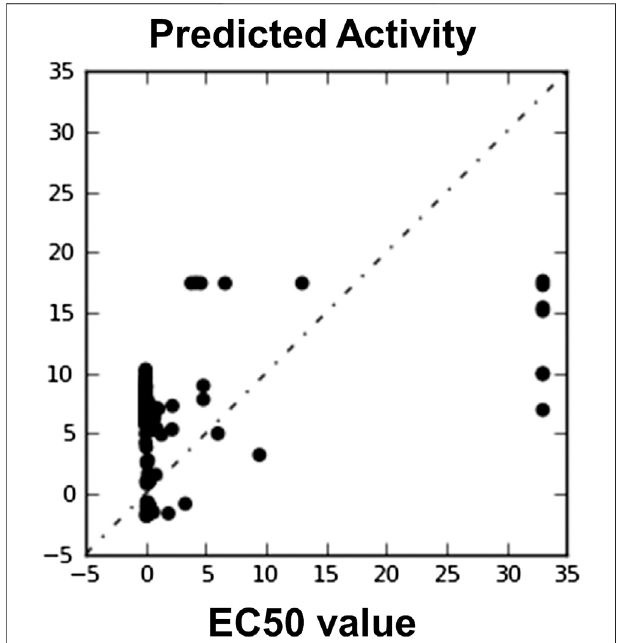
FIGURE8| Automaticallygeneratedregressionplotof3DQSARknown EC50 value and phase predicted activity, where X -axis signi fi es the EC50 score activity and Y -axis signi fi es the phase predicted activity of chemical